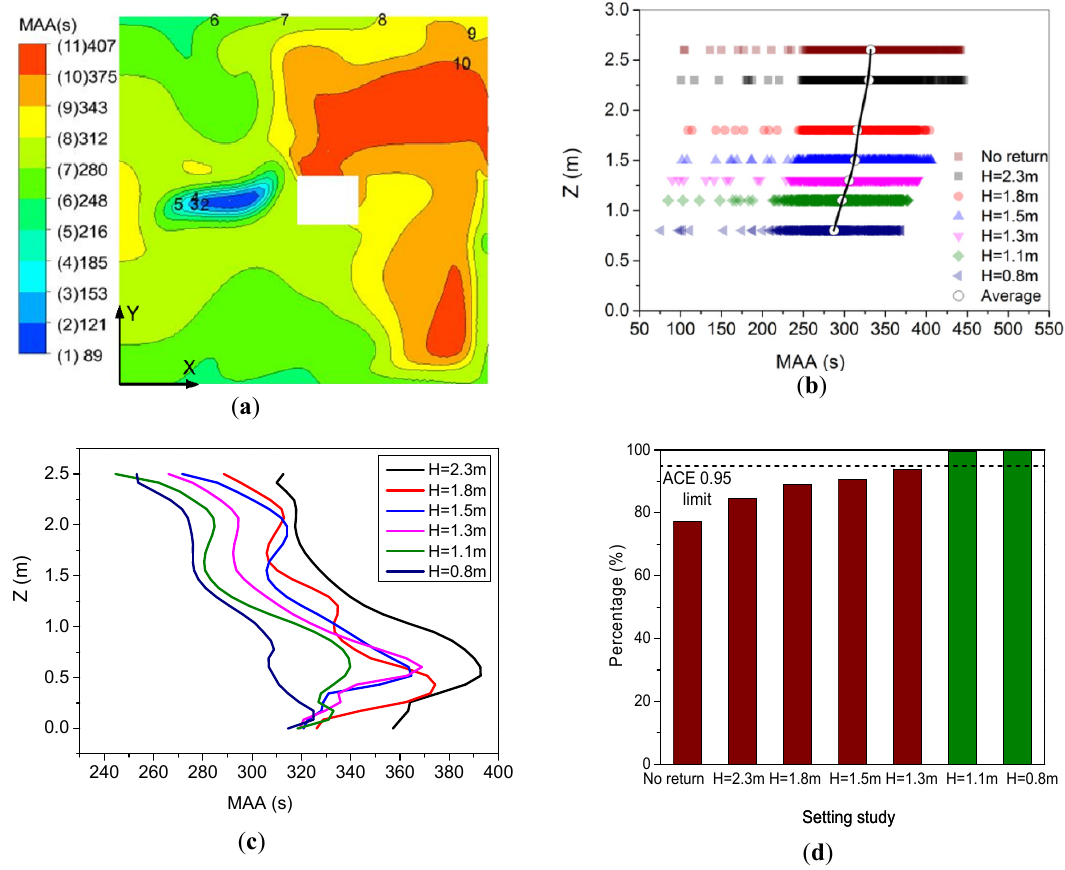
Figure 10. Mean air age (MAA) values distribution and a air change efficiency (ACE) percentage: ( a ) MAA value of H = 1.5 m setting at the Plane Z = 1.0; ( b ) Comparison of MAA values for seven settings at the Plane Z = 1.0; ( c ) MAA values profile along the room height in the vicinity of occupants; and, ( d ) ACE percentage in Plane Z = 1.0.